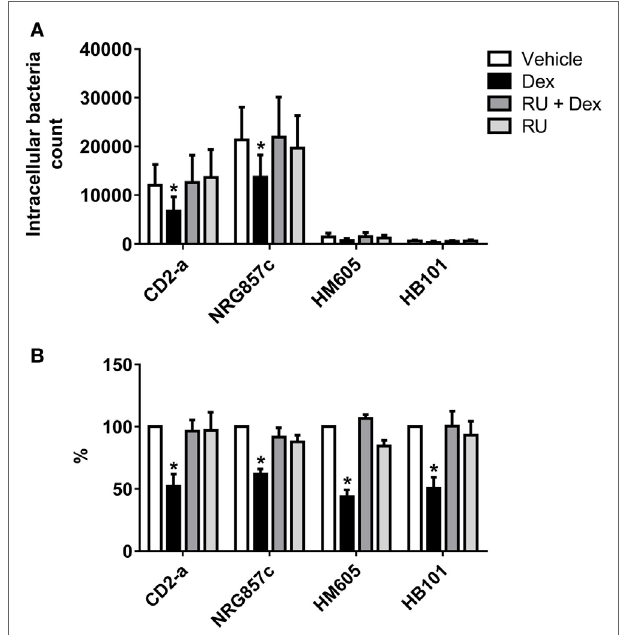
FigUre 5 | Dexamethasone decreases phagocytosis of macrophages against Escherichia coli strains. THP-1 macrophages treated with 100 nM Dex for 24 h were infected with E. coli strains (multiplicity of infection: 10). Amikacin protection assay was performed after 30 min of infection to evaluate phagocytic levels. (a) Absolute intracellular CFU count showing different quantities of phagocytosed strain inhibited by Dex. (B) Normalization to vehicle. Two-way ANOVA and Bonferroni corrections were performed ( n = 6; p < 0.05 compared to